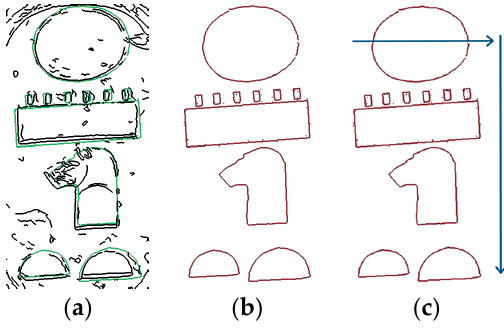
Figure 11. ( a ) Hieroglyphs extraction; ( b ) Hieroglyphs identification; ( c ) Reading sequence.